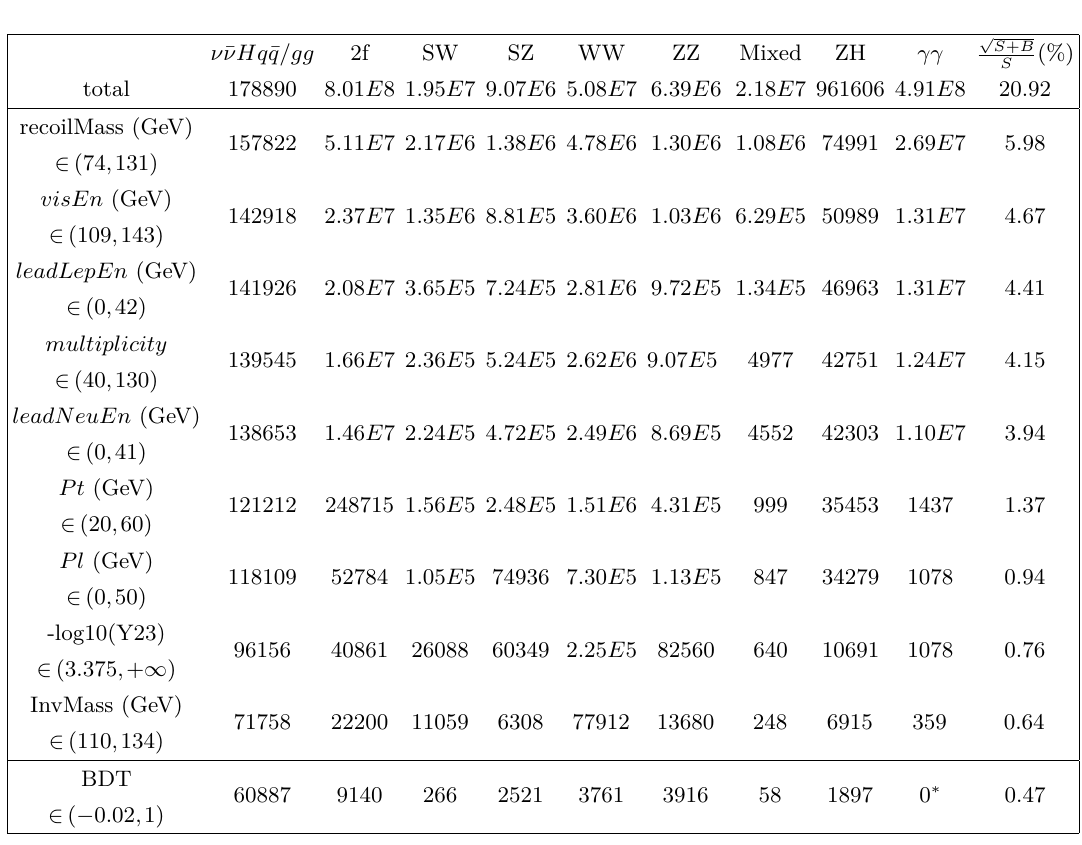
Table 1 . The event selection of ν ¯ νH ( H → q ¯ q/gg ) is based on the integrated luminosity of 5 . 6 ab − 1 . The γγ is the abbreviation for γγ → hadrons process. The symbol 0 ∗ represents that the number of γγ → hadrons events is less than 3 . 09 / 0 . 0028 at a confidence level of 95% according to Feldman- Cousins approach in the case of observing a zero event, where 3.09 is quoted from ref. [22] and 0.0028 is the scaling factor of the γγ → hadrons